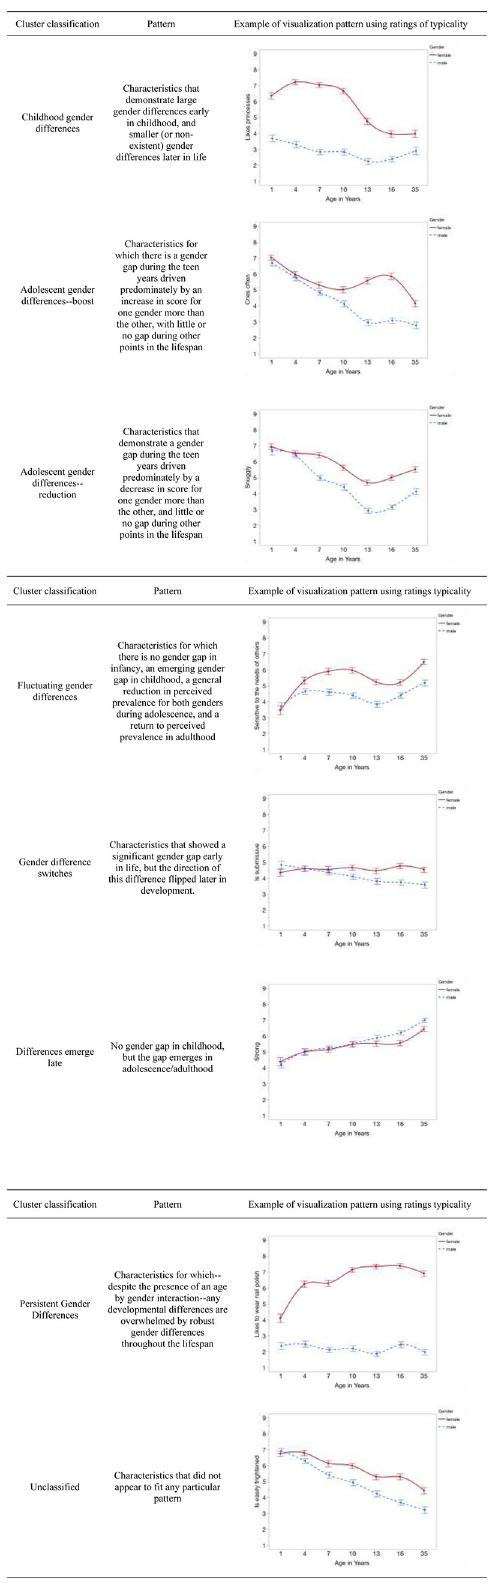
Fig 1. Observed clusters and their